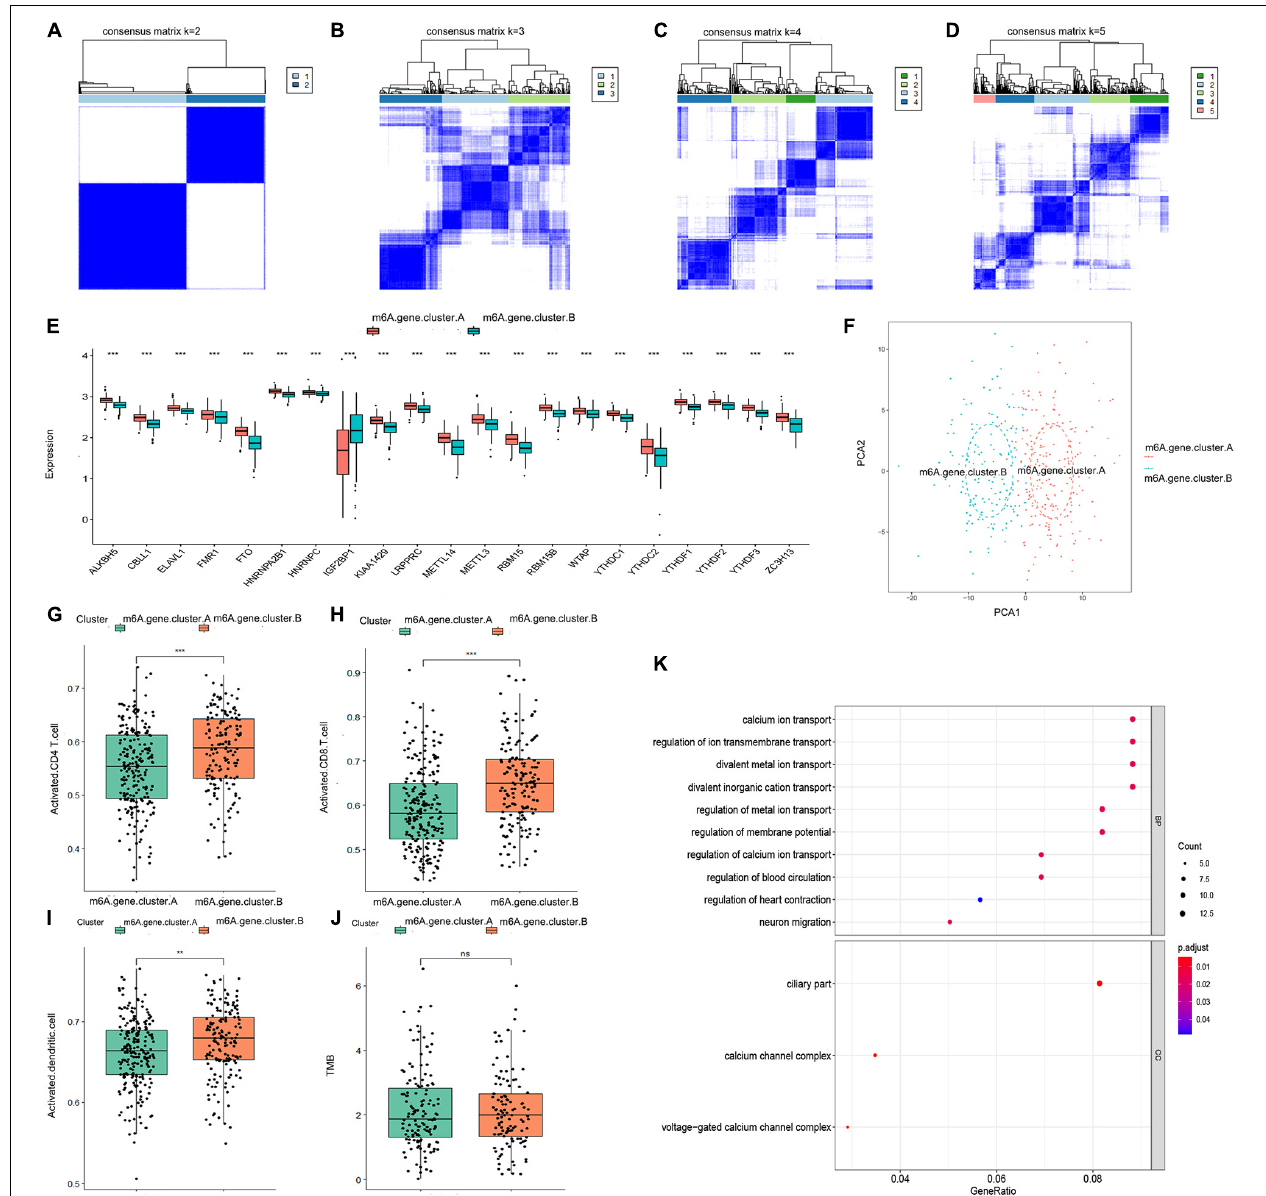
FIGURE 3 | Consensus clustering of the 196 m6A-related genes in TCGA-OV dataset. (A–D) Consensus matrices of the 196 m6A-related genes for k = 2–5. (E) Differential expression boxplot of the 21 m6A regulators in m6A.gene.cluster.A and m6A.gene.cluster.B. (F) PCA for the expression profiles of the 196 m6A-related genes, showing a remarkable difference in transcriptomes between the two m6A gene patterns. The variance of PCA1 was 45.23, while the variance of PCA2 was 14.94. Differences in the abundance of activated CD4 T cell (G) , CD8 T cell (H) , and dendritic cell (I) infiltrates between m6A.gene.cluster.A and m6A.gene.cluster.B. (J) Differences in the TMB level between m6A.gene.cluster.A and m6A.gene.cluster.B. (K) Gene ontology (GO) analysis exploring the potential mechanisms underlying the effect of the 196 m6A-related genes on the occurrence and development of ovarian cancer. “Count” represents “number of